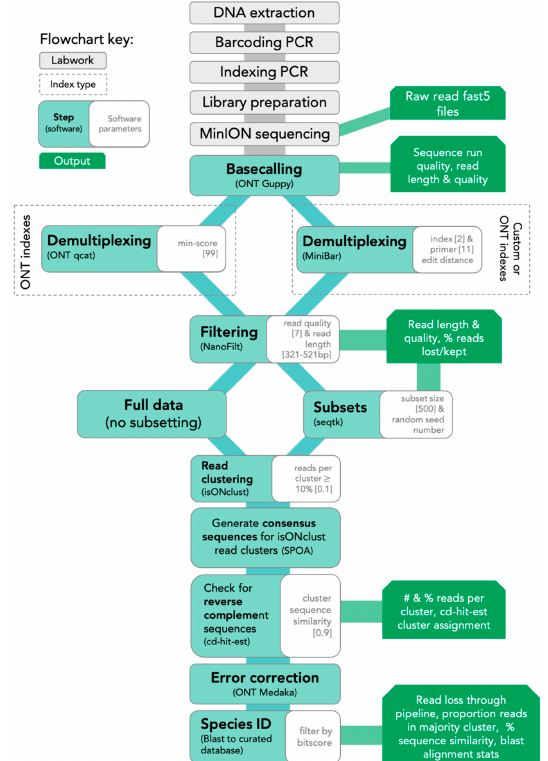
Figure 1. Lab and SAIGA bioinformatics pipeline flowchart. Bioinformatics software and parameters are indicated at each step.